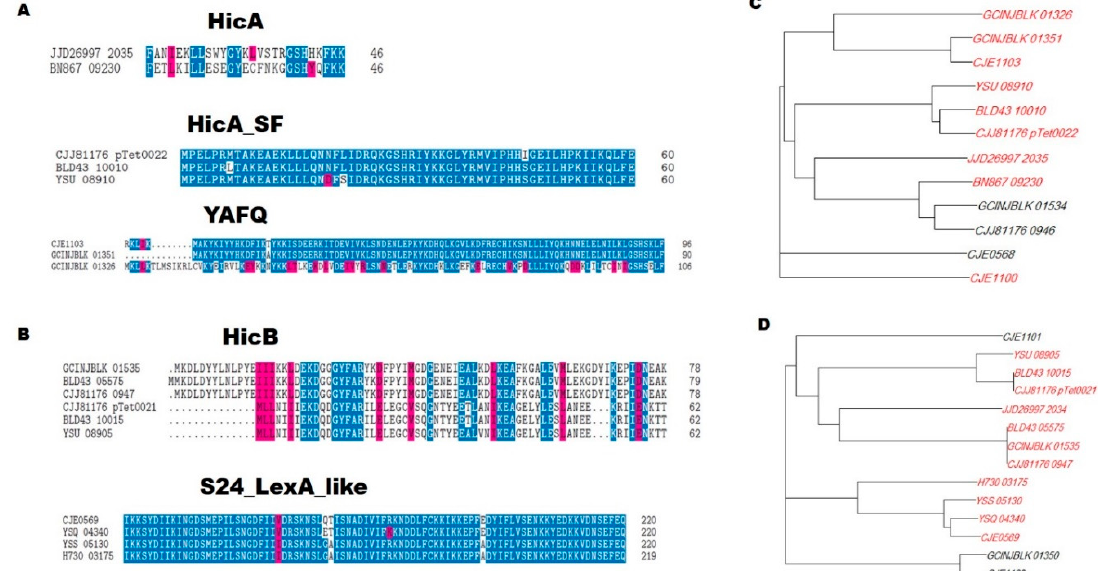
Figure 3. Multiple sequence alignment of locus tags for each domain. ( A ) Sequence alignment of toxin genes for each identified domain. ( B ) Sequence alignment of antitoxin genes for each identified domain. ( C ) Dendogram representing sequence clustering of all toxin genes, locus tags highlighted in red contain toxin domains. ( D ) Dendogram representing sequence clustering of all antitoxin genes, locus tags highlighted in red contain antitoxin domains. Residues highlighted in blue are ≥ 50% conserved, and those highlighted in pink show similar residues.